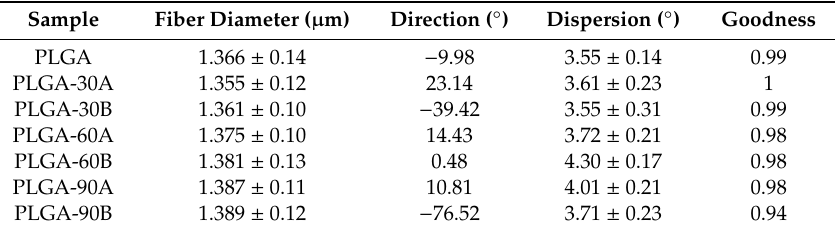
Table 2. Fiber alignment of the untreated and CAP treated PLGA microfibers represented by direction, dispersion and